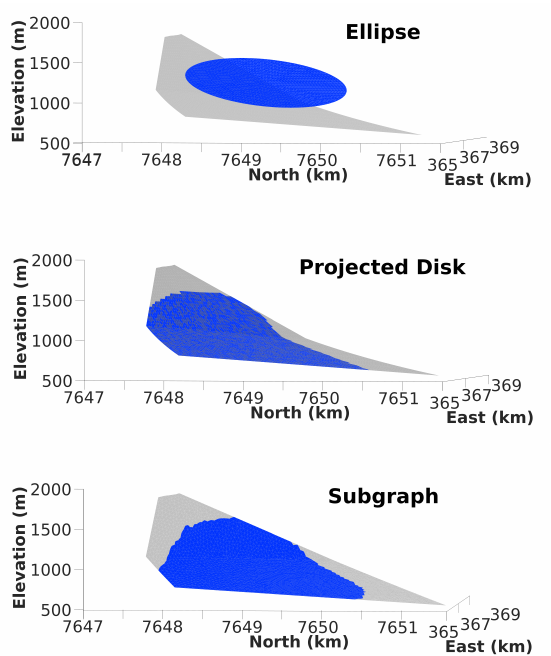
Figure 9. Comparison between the intrusion determined from InSAR data covering the whole eruption (grey) and the best model intrusion geometry (blue) resulting from the temporal inversion of GNSS data at 01:45. Results for the three different methods for inverting the pressure source are shown. ( Top ) Ellipse; ( Middle ) Projected Disk and ( bottom ) Subgraph methods.